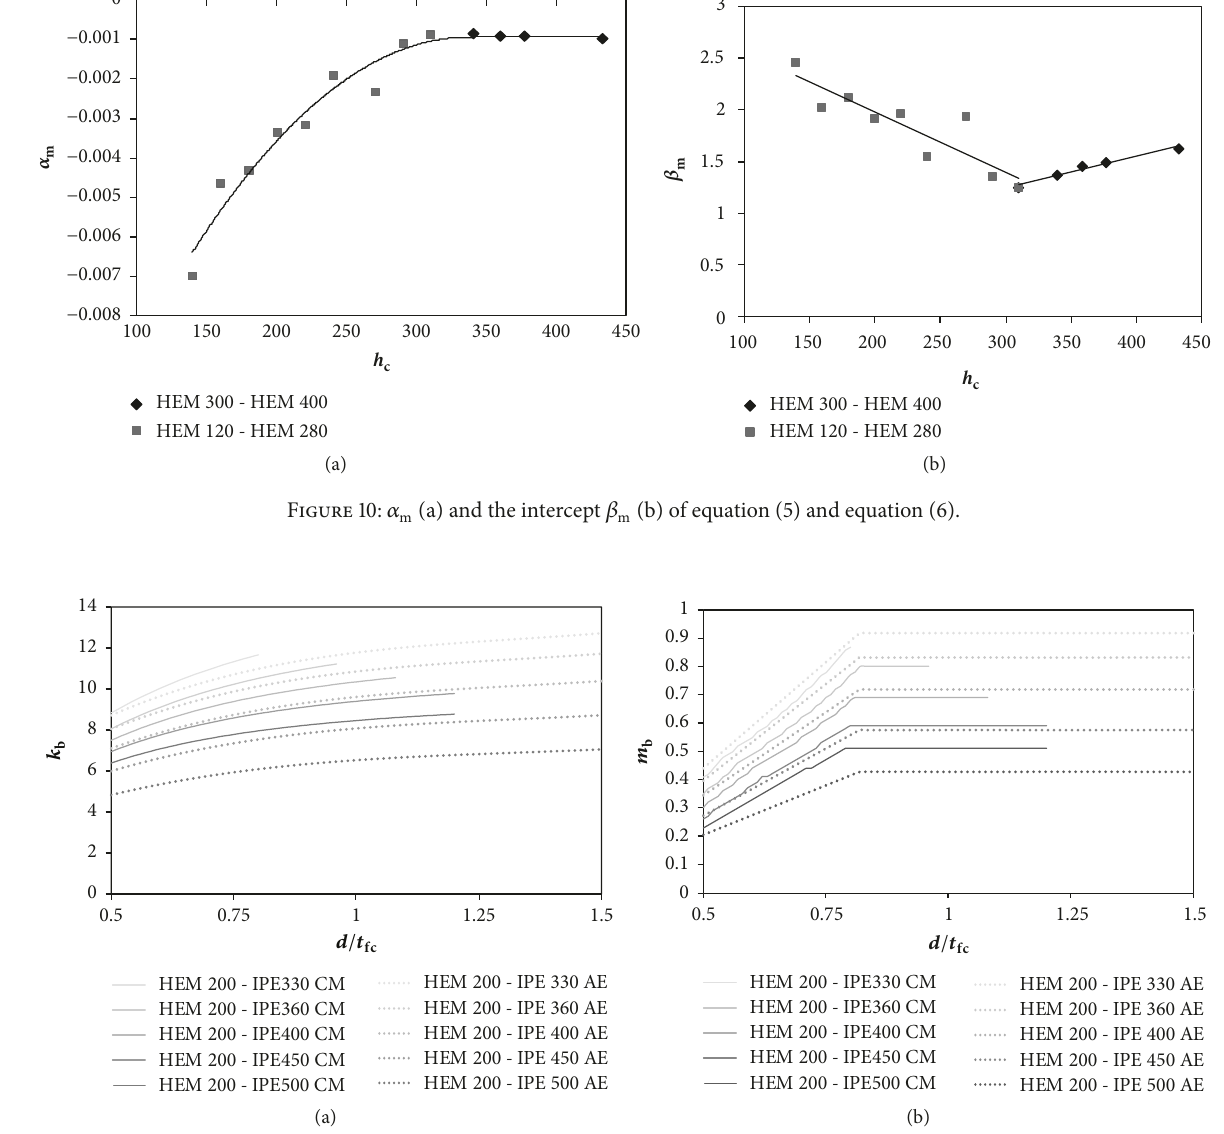
𝑑/𝑡 fc relationships obtained for the beam-to-column joints having a HEM 200 column cross